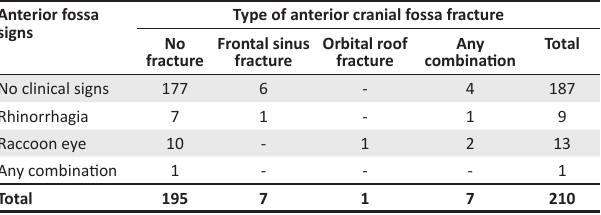
TABLE 1: Comparison of anterior cranial fossa clinical signs and fractures on computed tomography ( n = 210). Anterior fossa Type of anterior cranial fossa signs